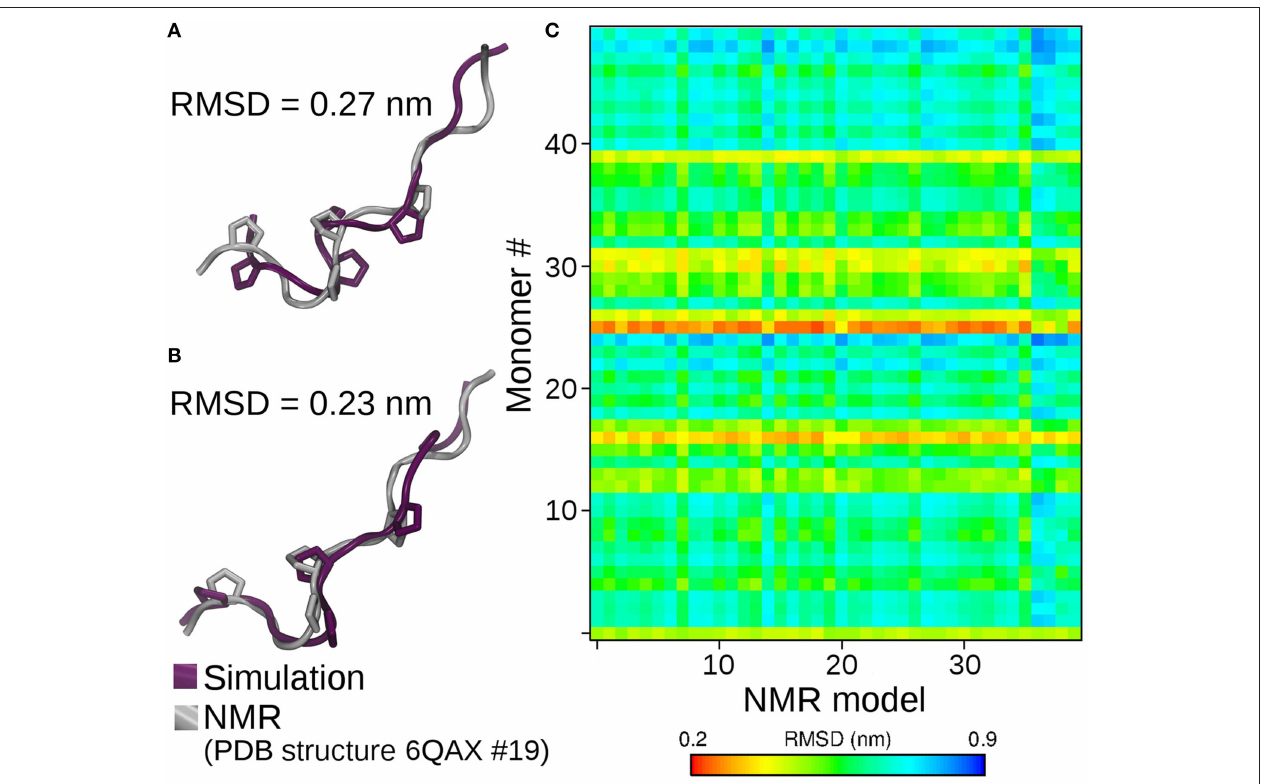
FIGURE 1 | Structural superposition of the best matching solution between NMR derived conformations and simulation of isolated peptides (A) , and peptides within the 50-mer aggregate (B) . On (C) , the final structures obtained by molecular dynamics of each peptide forming the oligomer (Y-axis) are compared against all the conformers reported in the NMR family of structures (X-axis). The degree of structural similarity is reported as the root mean square deviation (RMSD) between the C-alpha carbons of simulated and NMR derived conformers. Small RMSD values (red-yellow) identify high structural similarity. Simulations of P36A and F37A showed the same degree of structural similarity (not